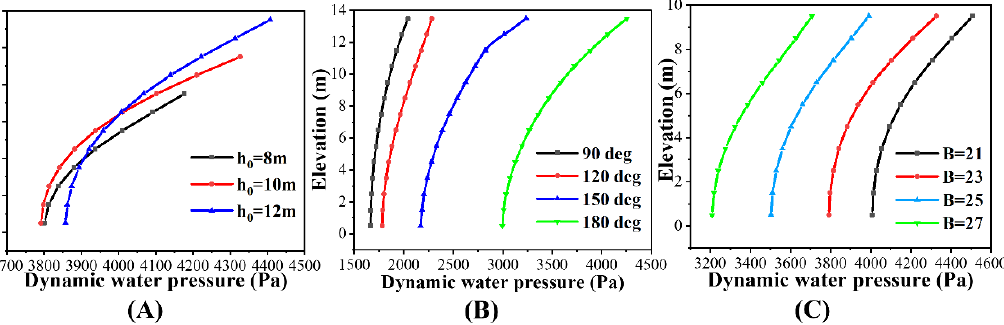
Figure 11. Distribution of dynamic pressure by elevation at different water depths, widths of water level and river bend angles: ( A ) water depth; ( B ) width of water level; ( C ) bending angle of river channel.